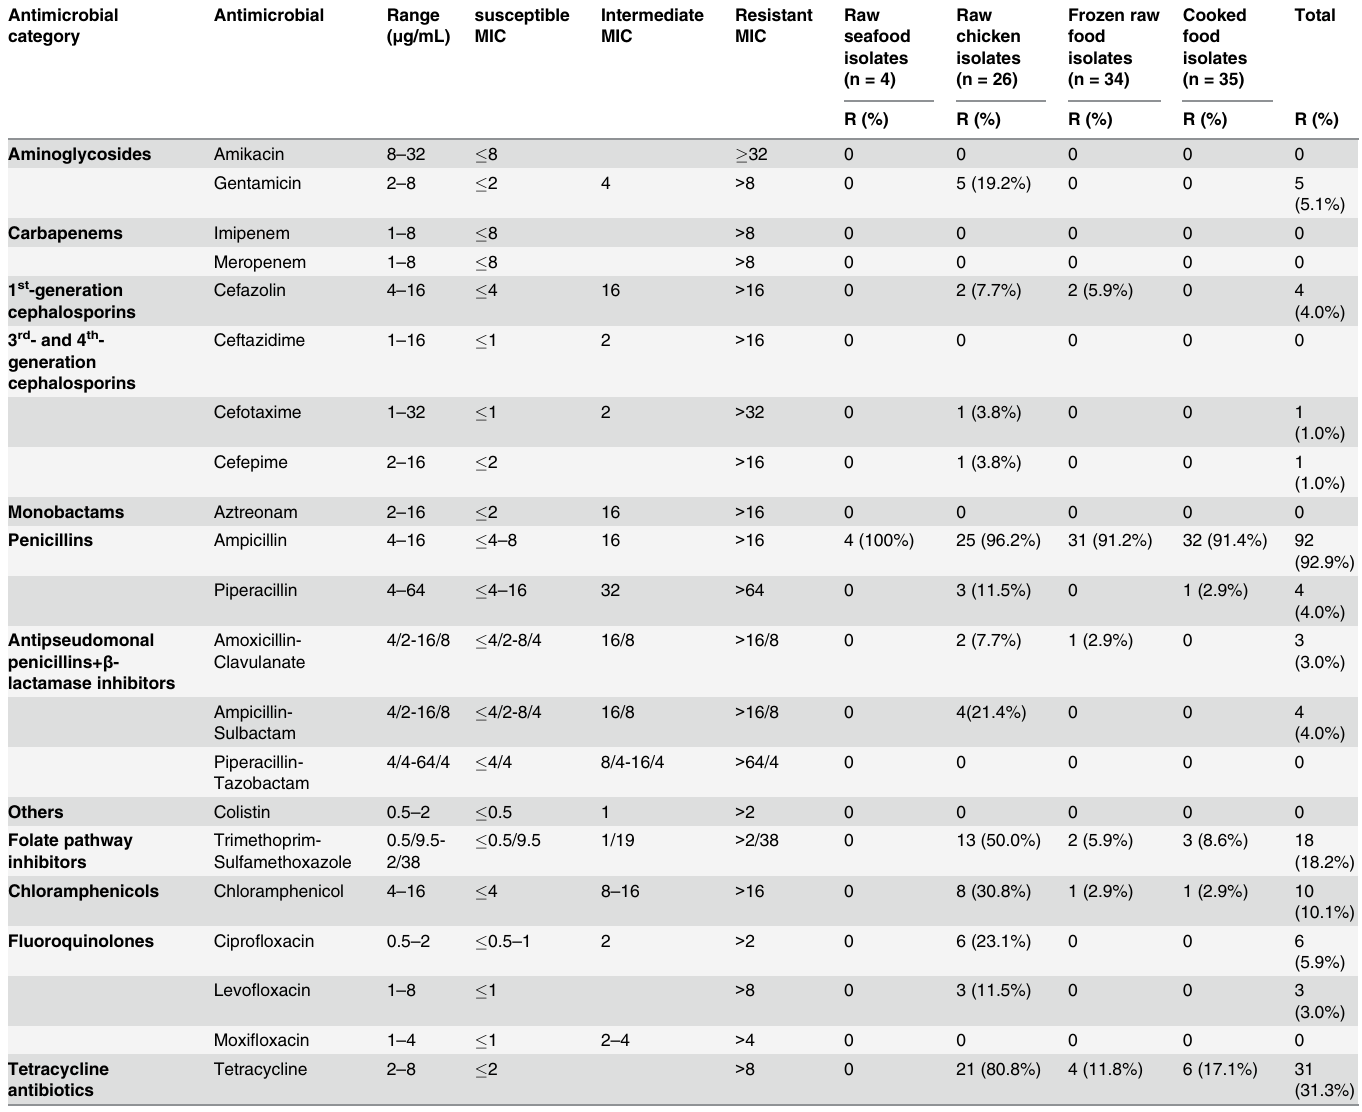
Table 2. Antimicrobial Resistance Rates of 99 K . pneumoniae